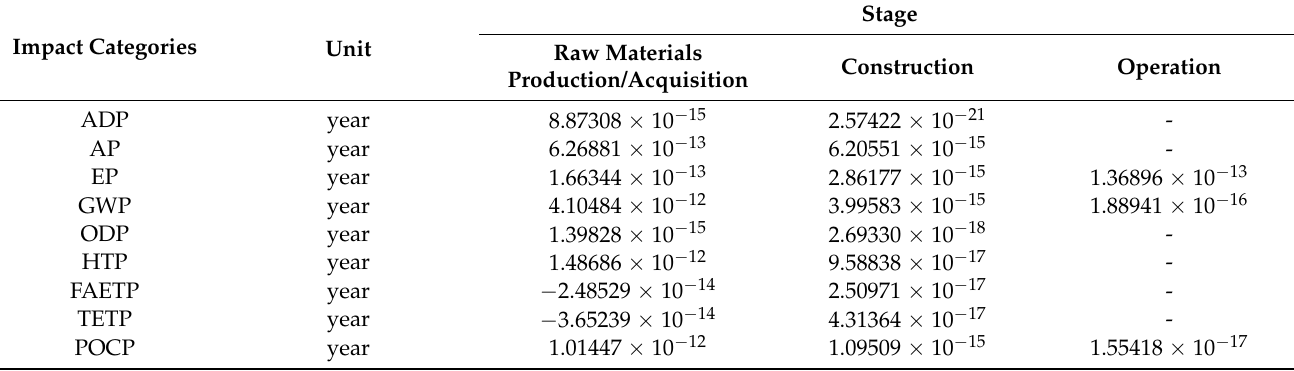
Table 4. Normalized values for floating wetland impact during raw material acquisition, construction, and operational stages.